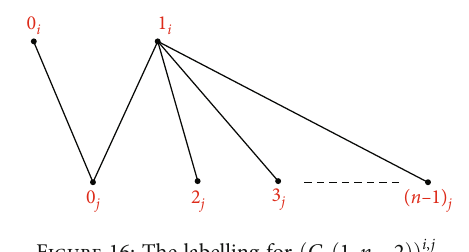
Figure 16: The labelling for ð C